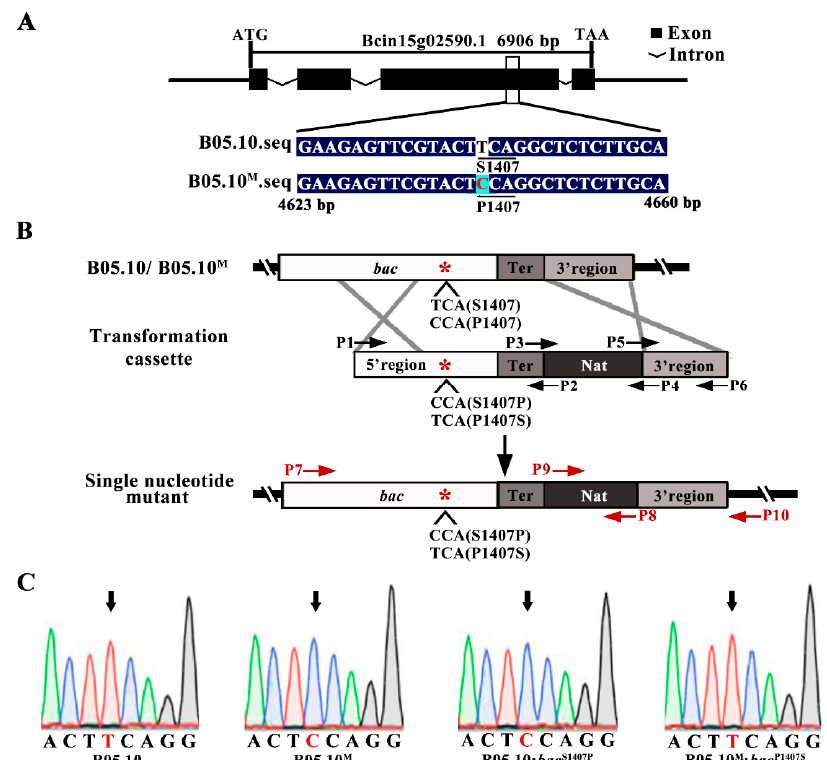
Figure 4. Structural diagram of the bac and construction of B05.10: bac S1407P and B05.10 M : bac P1407S strains. ( A ) Schematic representation of S1407P mutation in bac . Black boxes and broken lines indicate the location of exons and introns in the bac . Comparative alignment of nucleotide sequences of the target site (the region between 4623 and 4660 nucleotide positions) of B05.10 and B05.10 M were shown at the bottom. ( B ) Schematic representation of the in situ point mutation strategy to construct B05.10: bac S1407P and B05.10 M : bac P1407S strains. The asterisk (*), Ter, and Nat indicate the mutation site, terminator site, and nourseothricin resistance cassette, respectively. ( C ) Verification of single-nucleotide mutation sites (between nucleotide positions 4643 and 4650) by PCR-based Sanger sequencing. The mutation site is indicated by an